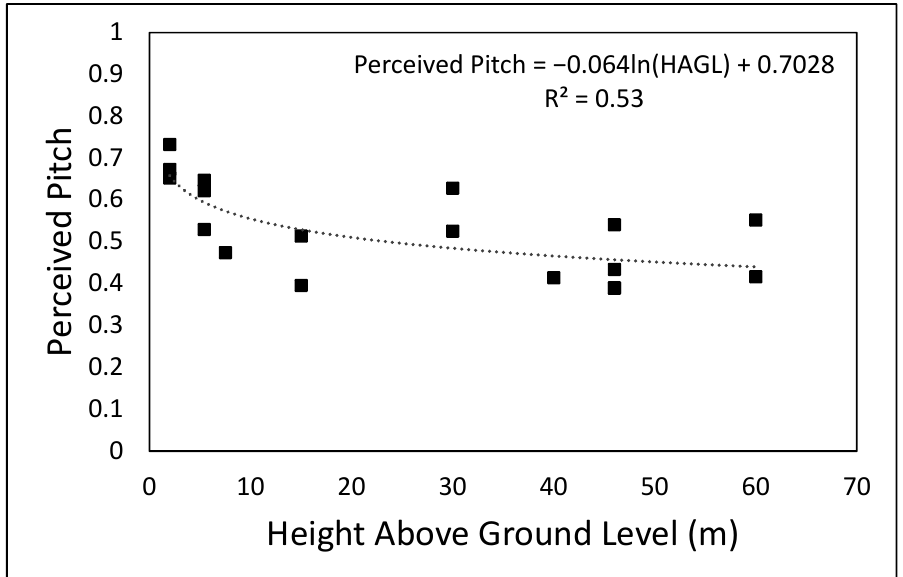
Figure 4. Perceived pitch vs. height above ground level of the unmanned aerial vehicles under investigation during flyover operation.